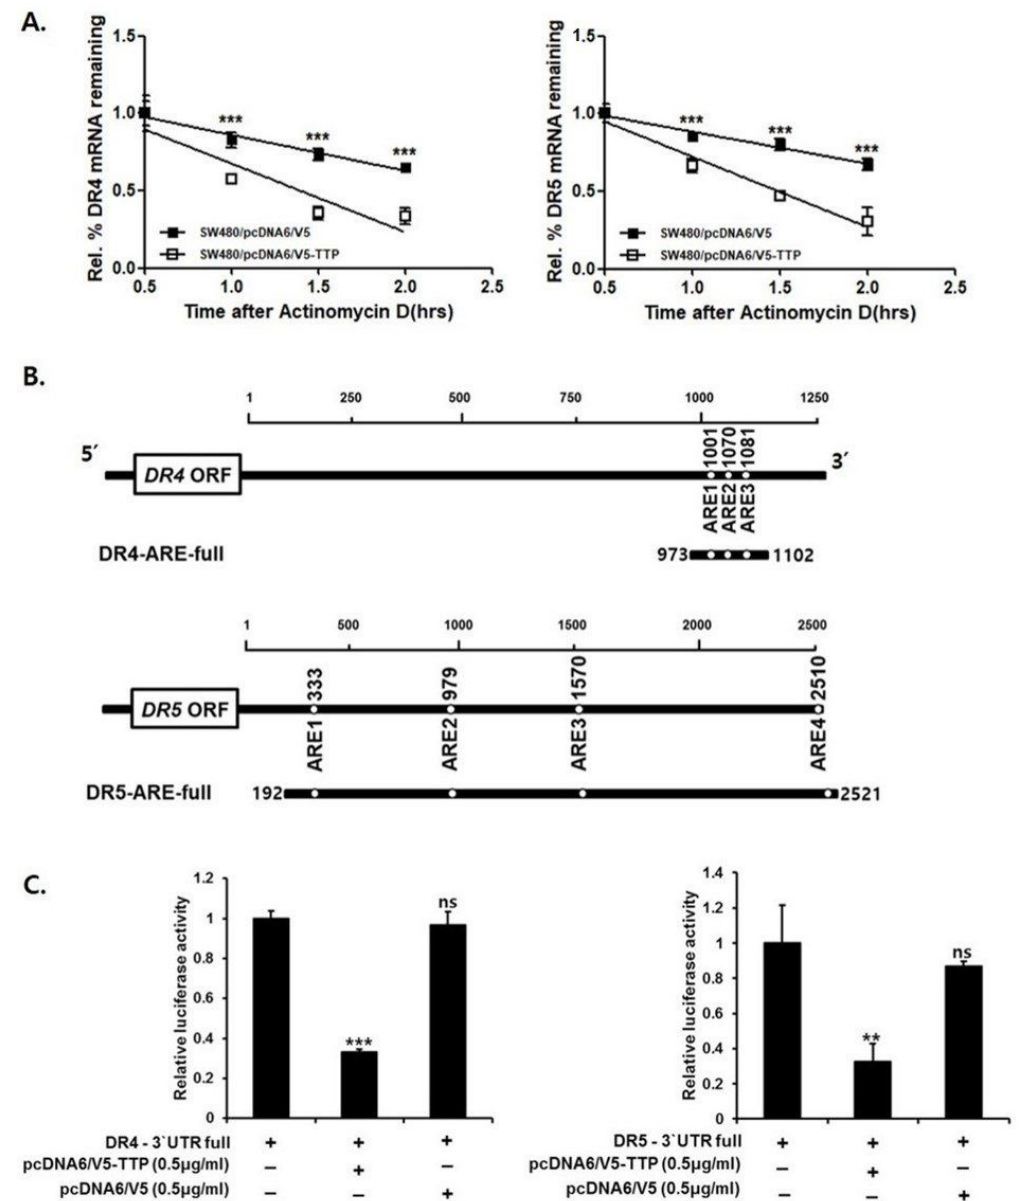
Figure 3. TTP destabilizes mRNA via interaction with ARE within DR4 / 5 mRNA 3 (cid:48) -UTR. ( A ) Expression of DR4 and DR5 mRNA in SW480 / pcDNA and SW480 / TTP cells was determined by quantitative real-time PCR at indicated times after adding 5 µ g / mL actinomycin D. mRNA half-life was calculated by nonlinear regression of mRNA levels at indicated times after addition of actinomycin D. Results shown represent mean ± SD of three independent experiments (*** p < 0.001). ( B ) Analysis of full base pairs of DR4 / 5 3 (cid:48) -UTR. Schematic representation of luciferase reporter constructs used in this study. Oligonucleotides derived from full-bp DR4 / 5 mRNA 3 (cid:48) -UTR were cloned downstream of the luciferase reporter gene in psiCHECK luciferase expression vector. White circles represent wild-type pentameric motif AUUUA. ( C ) Inhibition of luciferase reporter containing DR4 / 5 mRNA 3 (cid:48) -UTR by TTP overexpression. SW480 cells were co-transfected with 500 ng of psiCHECK luciferase reporter construct containing full AREs in DR4 / 5 and pcDNA6 / V5-TTP or empty vector pcDNA6 / V5. After normalization, luciferase activity from SW480 cells transfected with psiCHECK vector alone was set to 1.0. Results represent the mean ± SD of three independent experiments (** p < 0.01; *** p < 0.001). ORF, open reading frame; ns, not